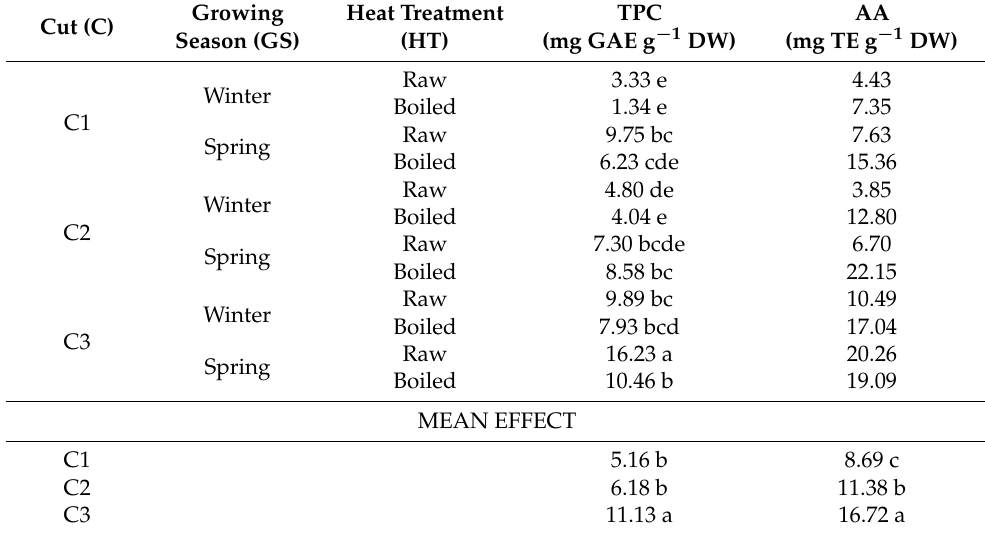
Table 3. Total phenolic content (TPC) and antioxidant capacity (AA) in raw or boiled leaves of Malva sylvestris hydroponically grown under greenhouse in winter or in spring and subjected to three consecutive cuts (C1, C2, C3). Data keyed with different letters are significantly different for p < 0.05 following three-way ANOVA and Tukey’s HSD post-hoc test for the effect of growing season, cut and